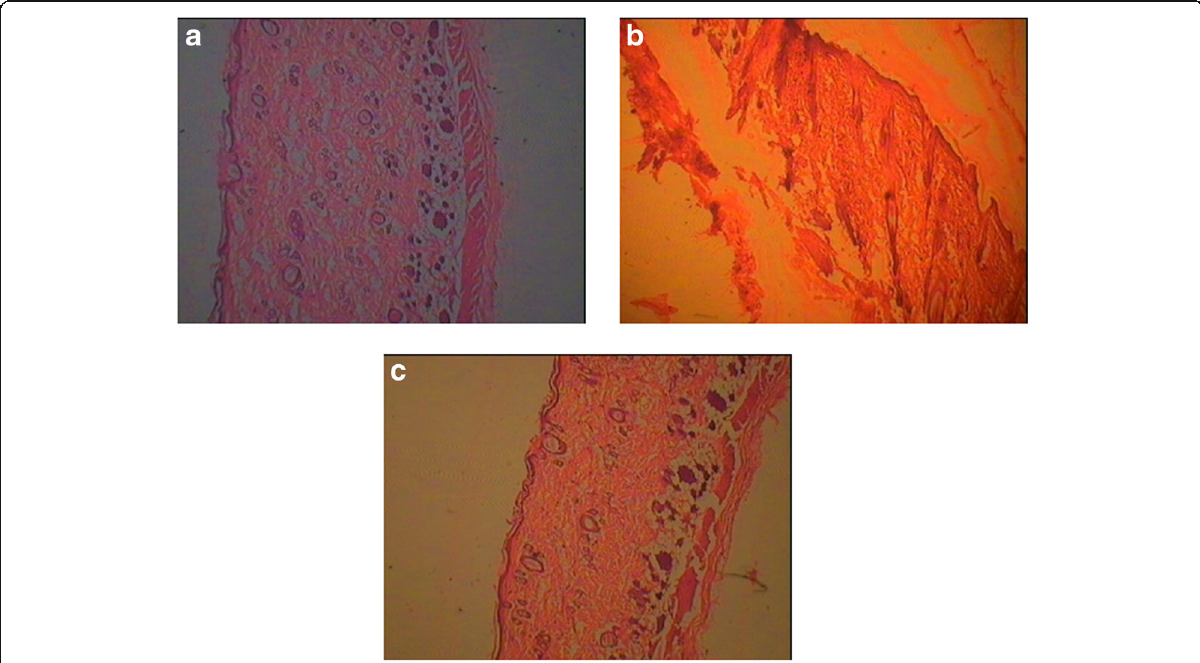
Fig. 4 Histopathology of Normal, Psoriasis and Test treated test ( a : Naïve Control, b : Psoriasis Induced, c : Test